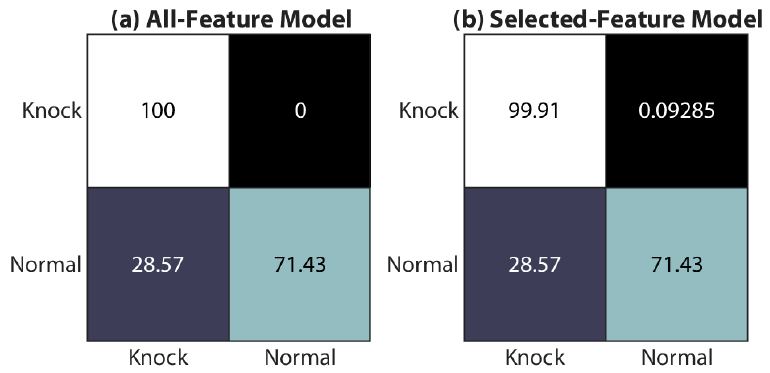
Figure 14. Classification accuracies of original and retrained models with the second experiment dataset.